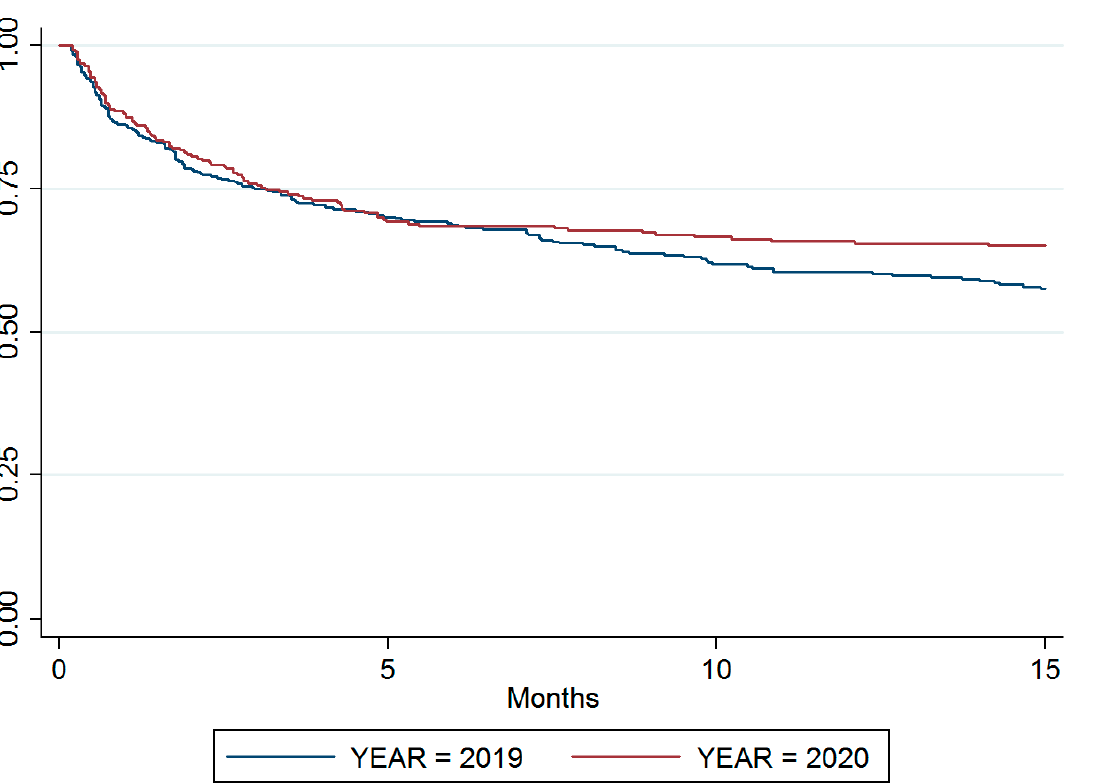
Figure 4. Distribution of circulating albumin ( A ), C -reactive protein (CRP) ( B ), and lymphocytes ( C ) as well as the correlation between albumin and CRP levels ( D ) in patients admitted in 2019 and 2020. Differences were computed by two-tailed Student’s t -tests ( A – C ). Correlation ( D ) analysis